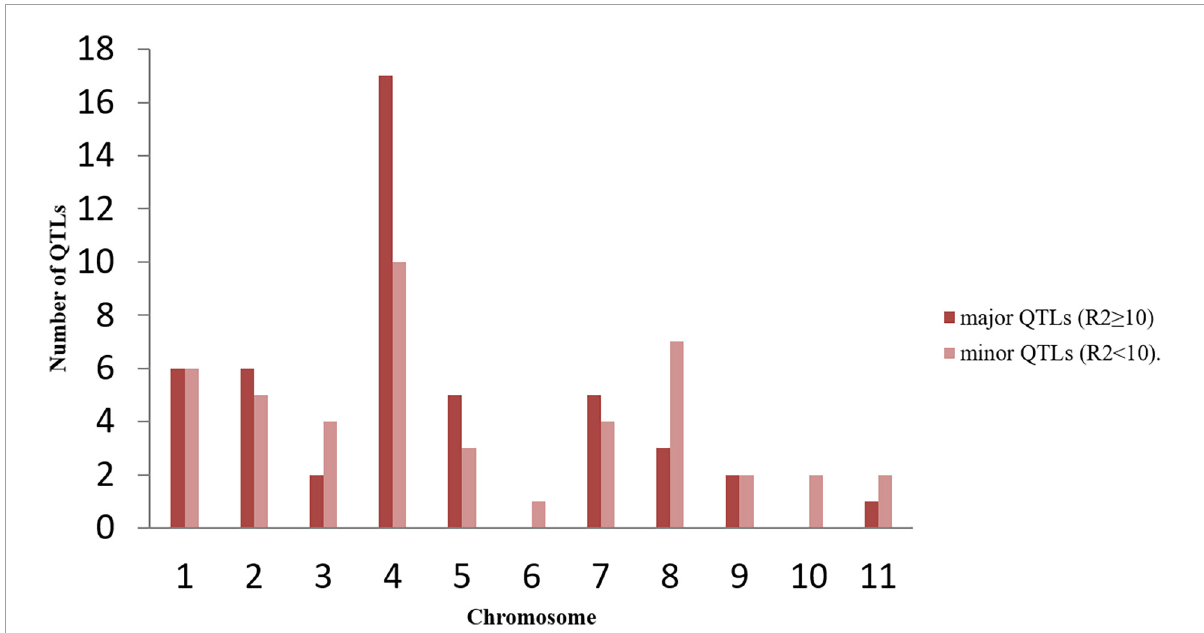
FIGURE1 Distribution of major ( R 2 ≥ 10) and minor ( R 2 < 10) QTLs on different common bean chromosomes used in meta-QTL analysis during the present study. The figure shows maximum number of QTLs are present on chromosome 4.